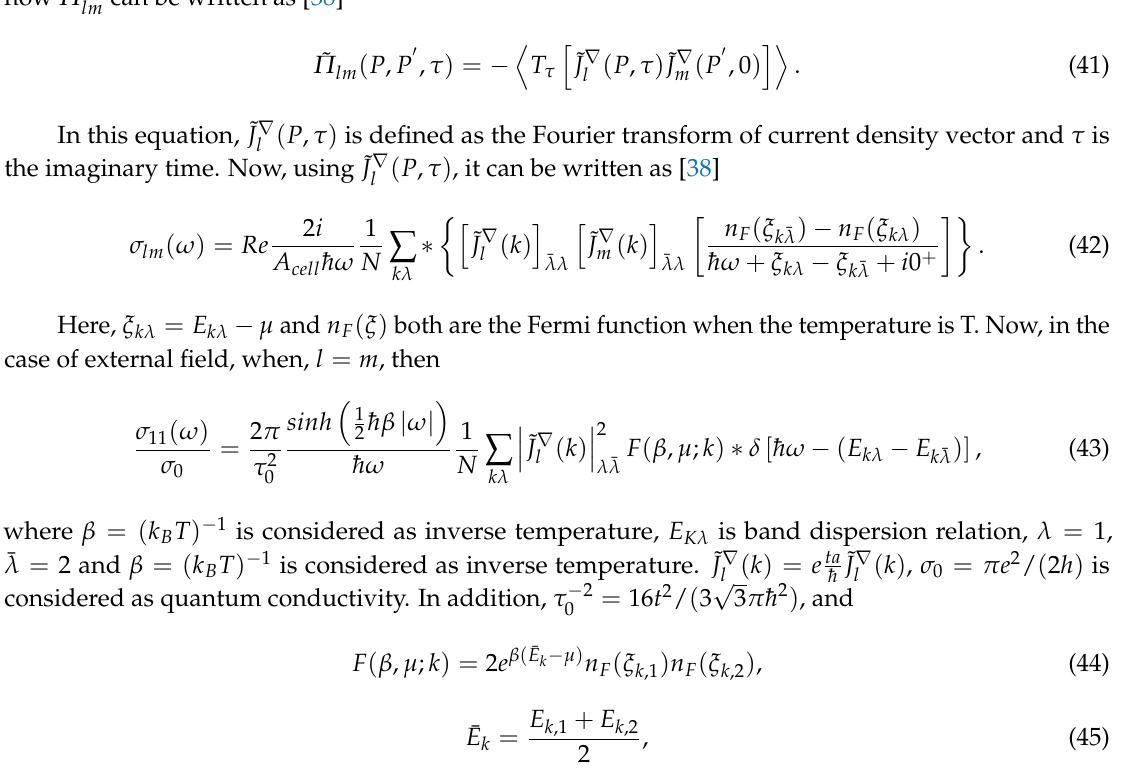
Figure 7 indicates the strain applied optical conductivity and field orientation ratio considering frequency